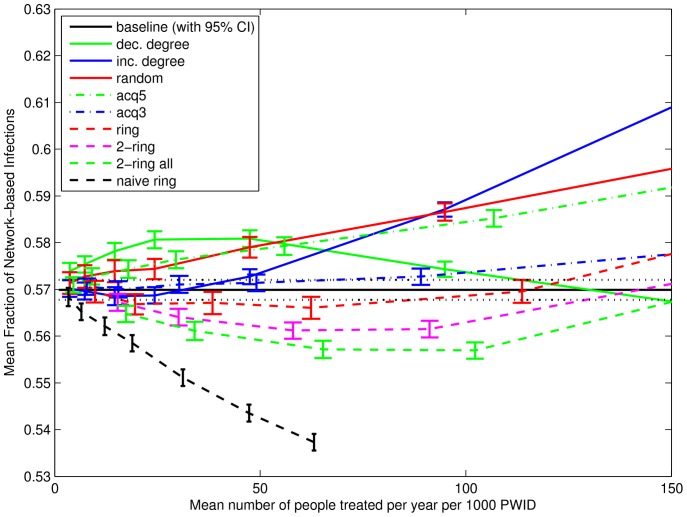
Mean proportion of infections that are network-based.Vertical coordinate shows the mean proportion of new infections in weeks 131–156 that are network-based (i.e., not imported), calculated as the mean proportions across 500 simulations and then the mean (with 95% confidence interval) across 100 networks. Horizontal coordinate shows the mean number of treatments started in weeks 1–156, calculated as the means across 500 simulations per network, then the mean across 100 networks, and then the mean across 3 years. Strategies that choose high-risk nodes (i.e., more primary contacts) at random while ignoring the infection status of some (“acq5”) or all (“dec. degree”, “random”) primary contacts show a larger fraction of network-based infections. At higher treatment frequencies, “inc. degree” shows an increasing fraction of network-based infections as higher-risk nodes are treated. The “naive ring” strategy, which treats the primary contacts of randomly-chosen never infected nodes (if they exist), effectively reduces network-based transmission.